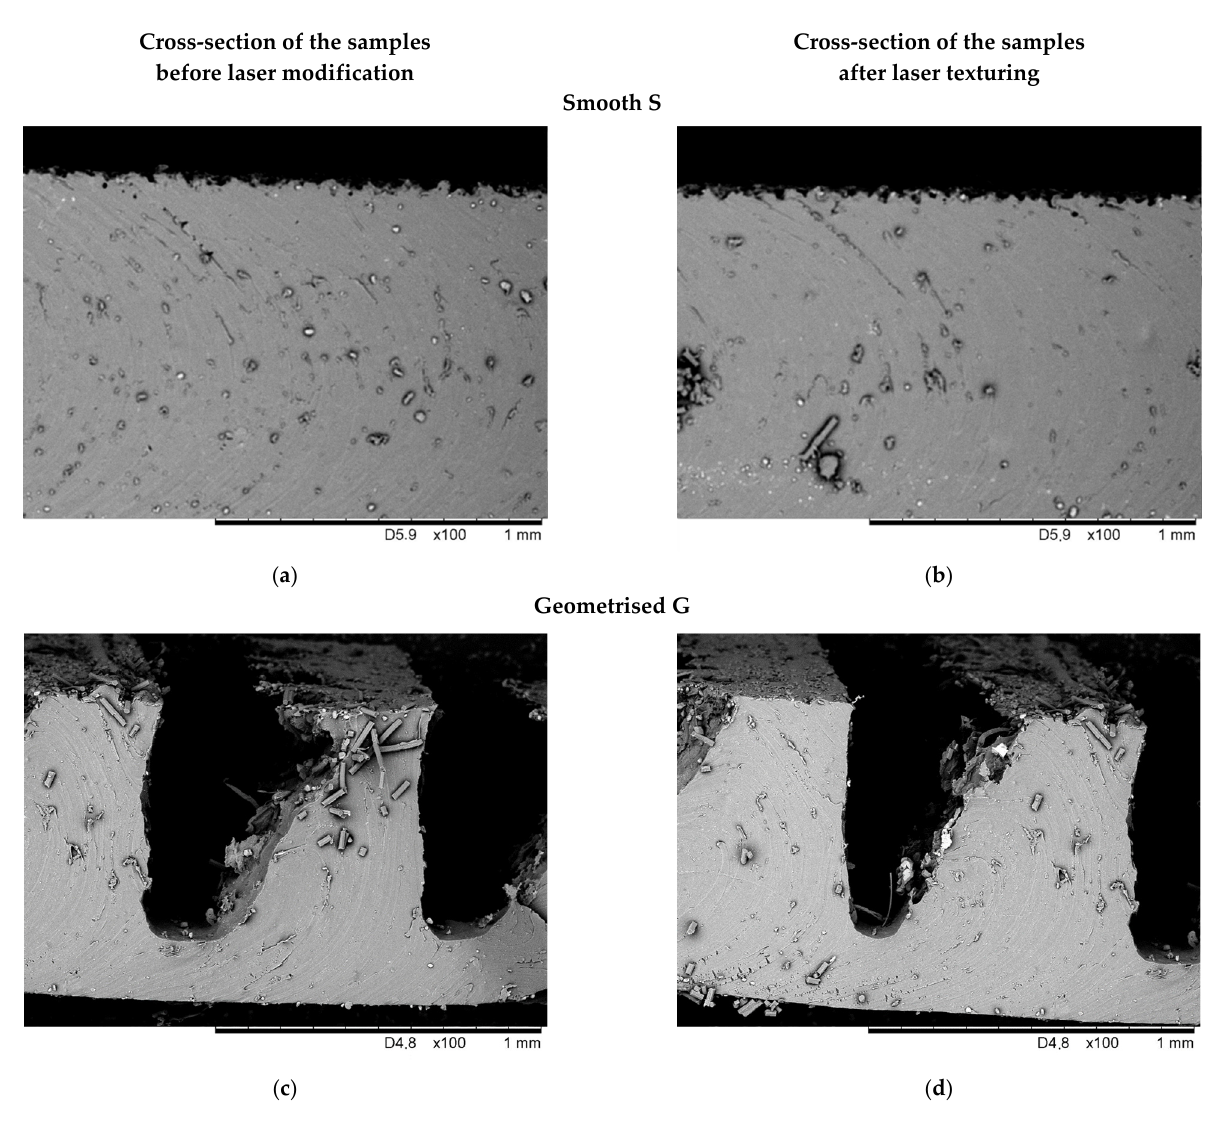
Figure 7. Scanning electron microscope (SEM) image of the samples’ cross-section before and after laser texturing: ( a , c ) cross-section of the smooth and geometrised samples before laser modification; ( b , d ) cross-section of the smooth and geometrised samples after laser